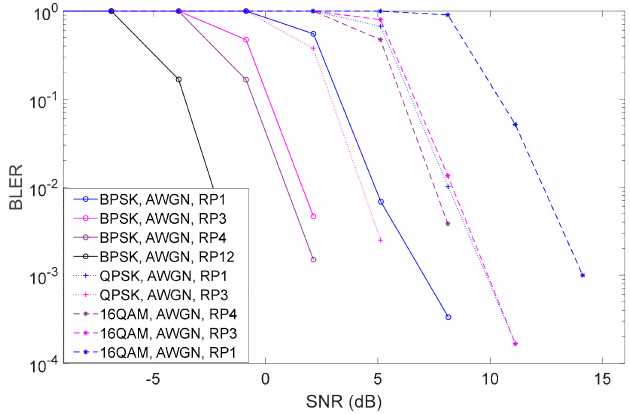
Figure 3. Excess delay versus normalized power of terrestrial winner II (B1 scenario) channel model.